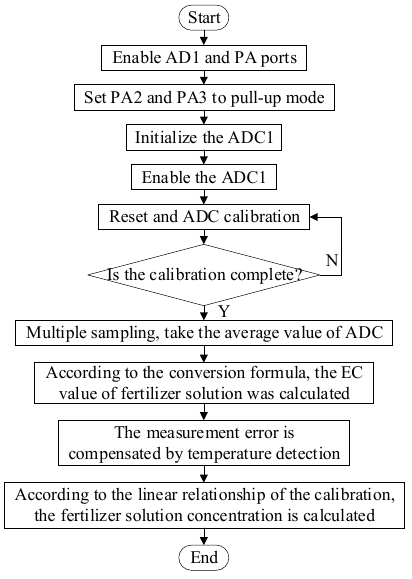
Figure 3. Flowchart of fertilizer concentration detection.